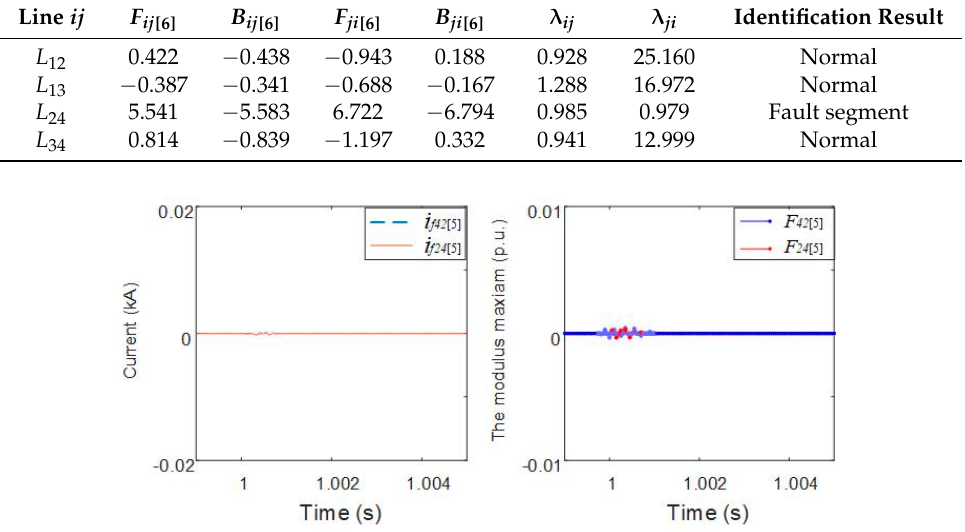
Figure 12. Simulation results of fifth mode FTWC for f 3 fault.